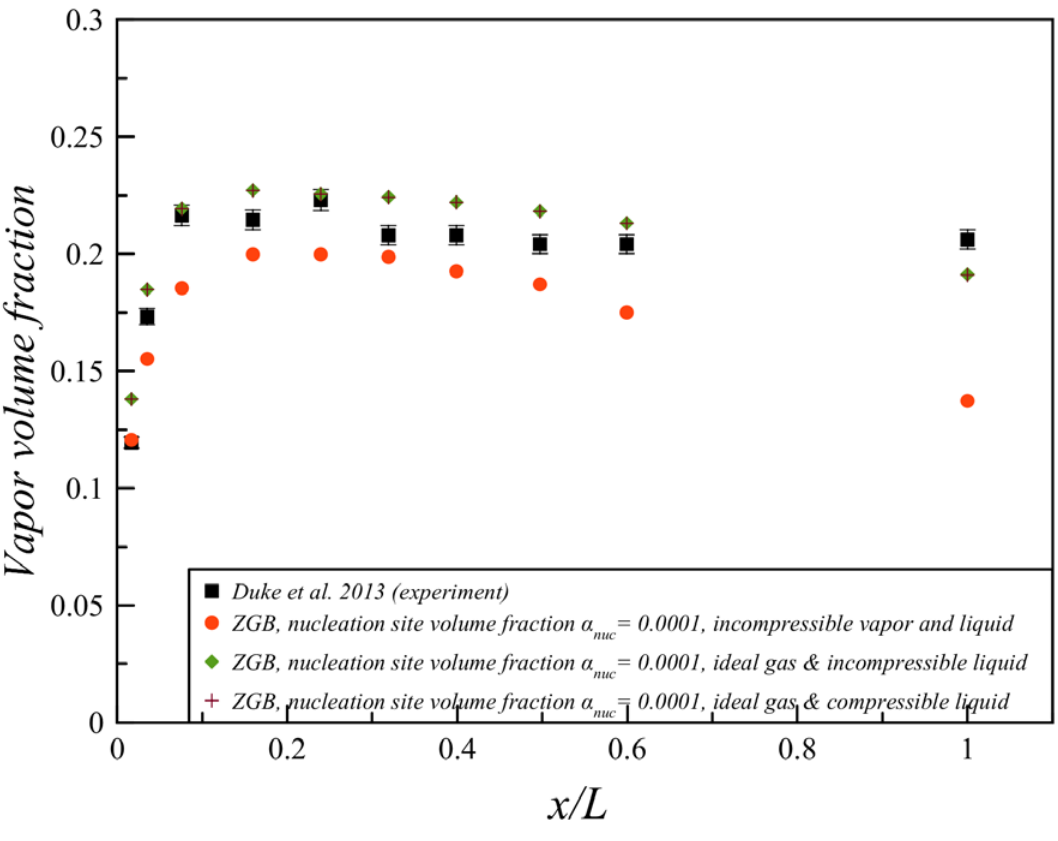
Figure 14. Influence of compressibility on total vapor volume fraction at different axial positions along the nozzle.